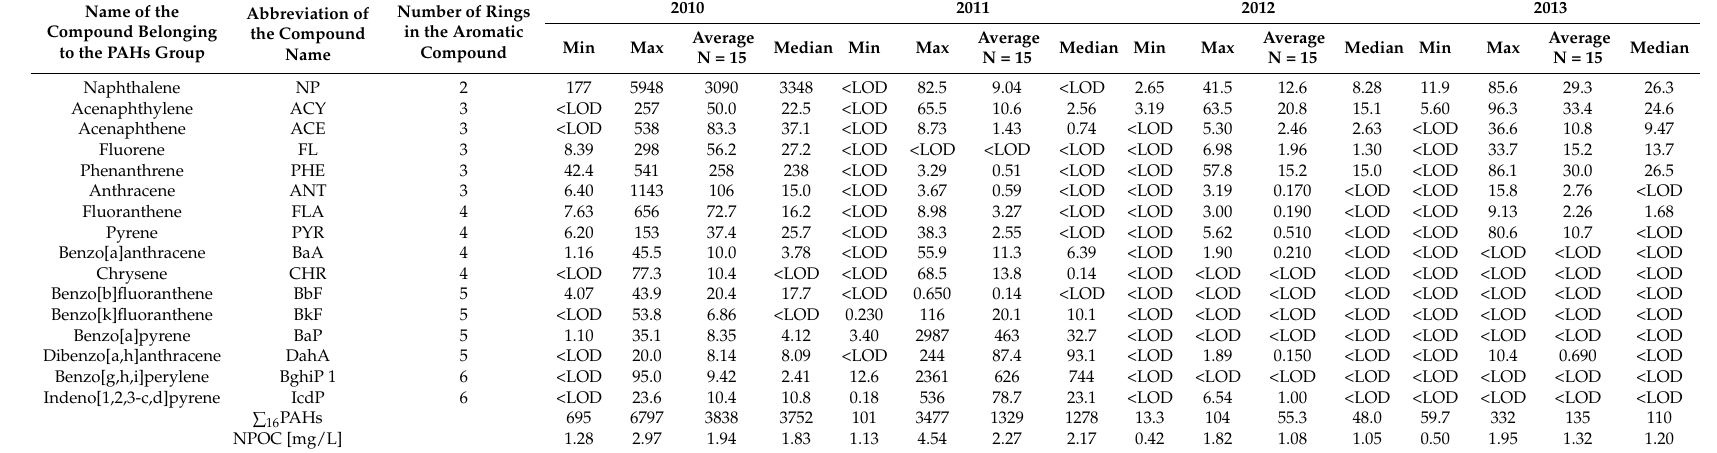
Table 4. Minimum, maximum, median and mean concentrations (ng/L) of different compounds determined in Fuglebekken